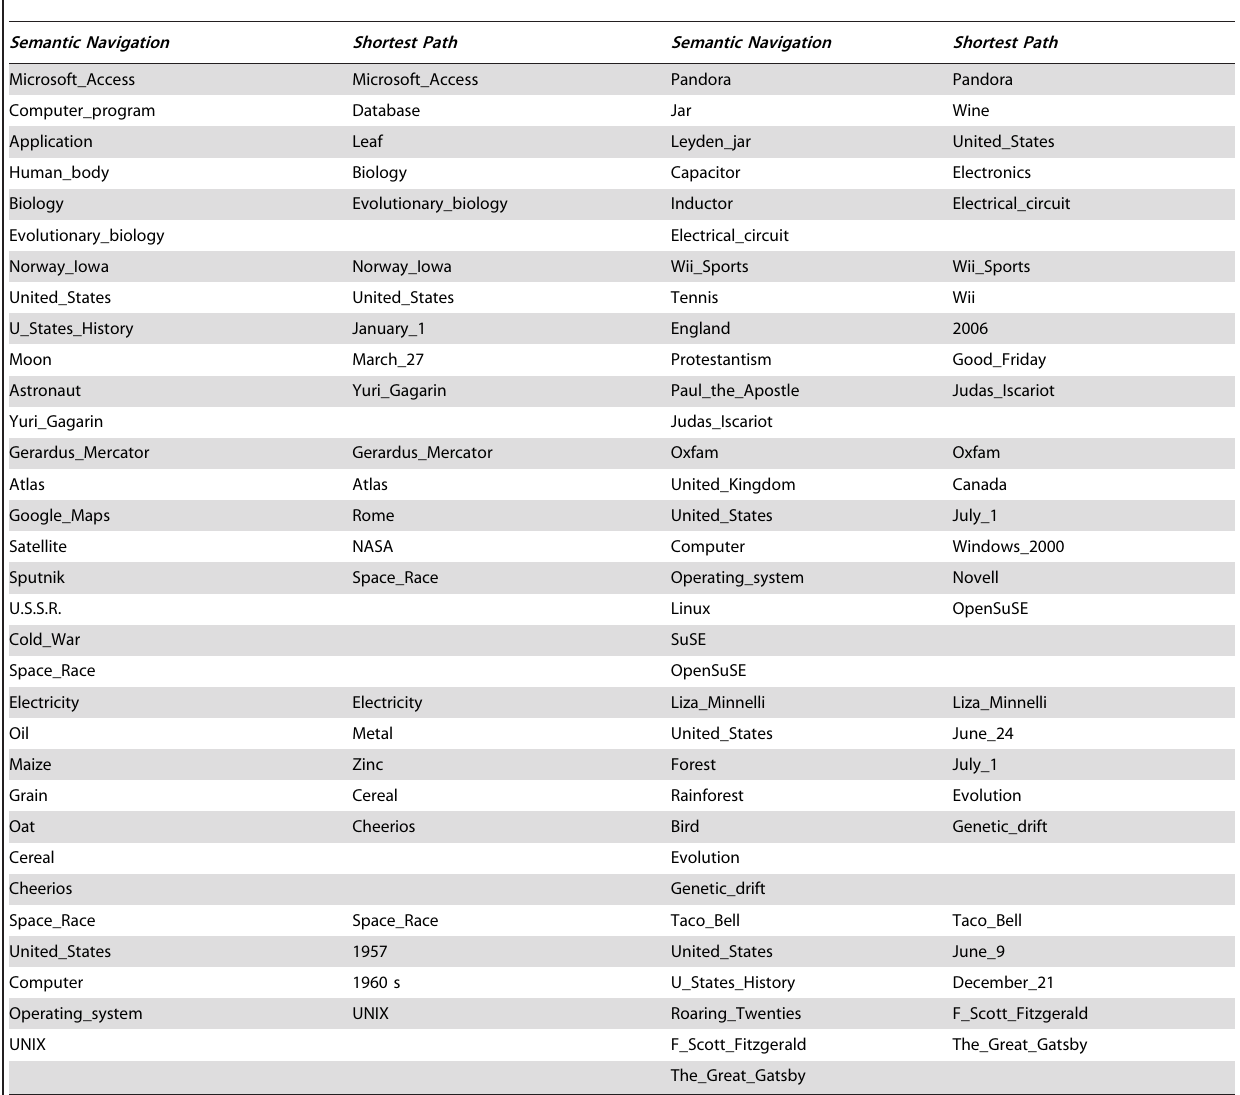
Table 1. Comparison between semantic navigation and shortest path for a sample of source and target pairs of words.